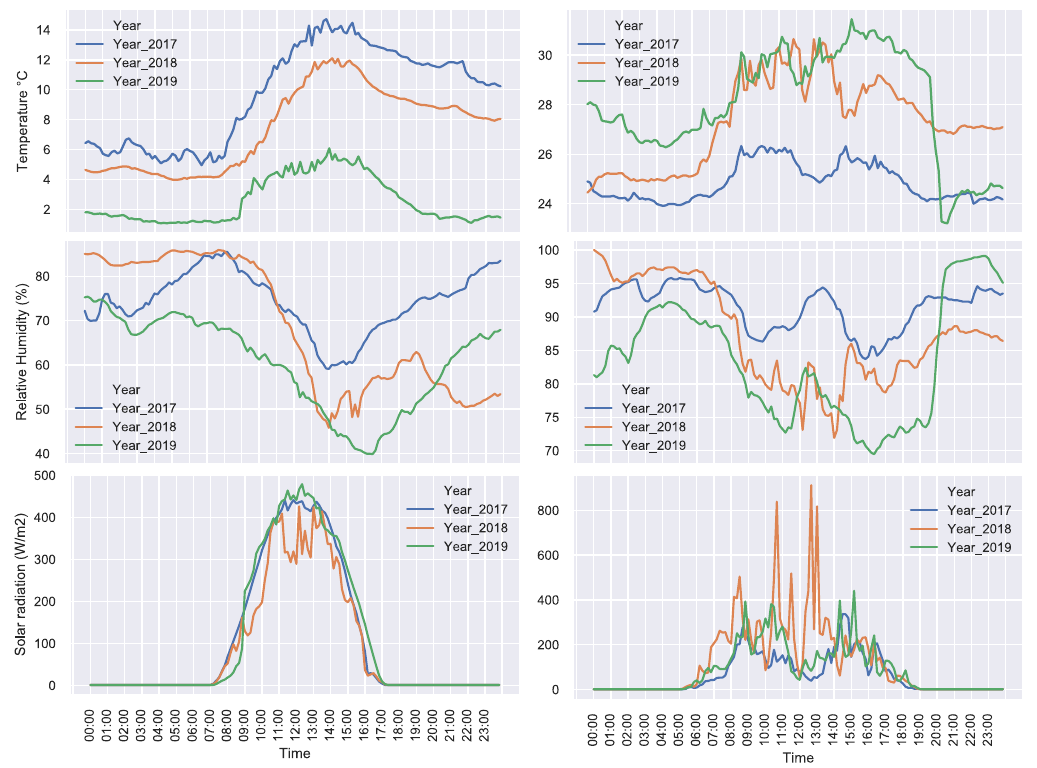
Figure A1. The example of distribution of temperature, relative humidity, and solar radiation respectively for typical days (1 January and 1 July) for three years.